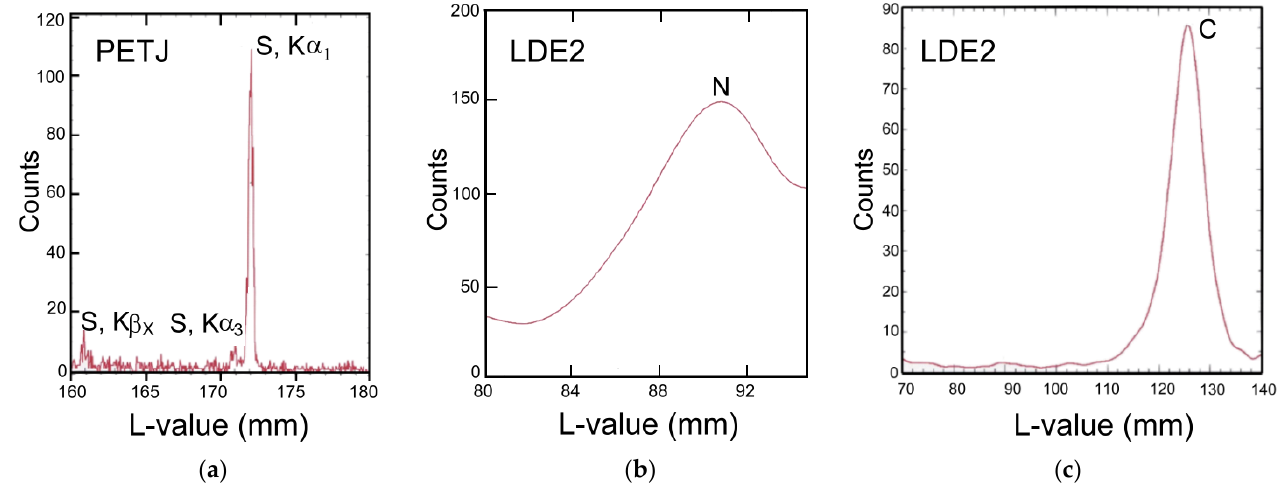
Figure 7. ( a ) Electron probe micro-analyzer (EPMA) measurement result of sulfur from V- CB(PANI); accelerating voltage = 3.0 kV; irradiation current = 3.94 × 10 − 9 A, PETJ is the analyzing crystal, PET = pentaerythritol ; ( b ) EPMA measurement result of nitrogen from V-CB(PANI), accelerating voltage = 15 kV, irradiation current = 2.355 × 10 − 7 A, LDE2 is the analyzing crystal, LDE = artificial layered dispersive element crystals; ( c ) EPMA measurement results of carbon atoms; accelerating voltage = 3 kV; irradiation current = 3.949 × 10 − 9 A, L-value is the distance from a spectrometer to the sample.